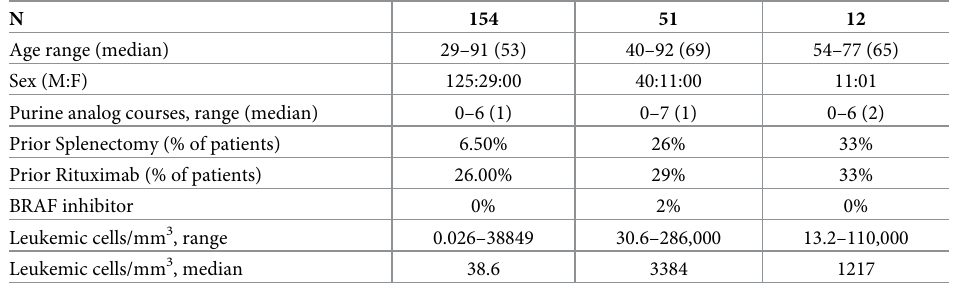
Table 2. HCL/HCLv patients tested for Myf6 by